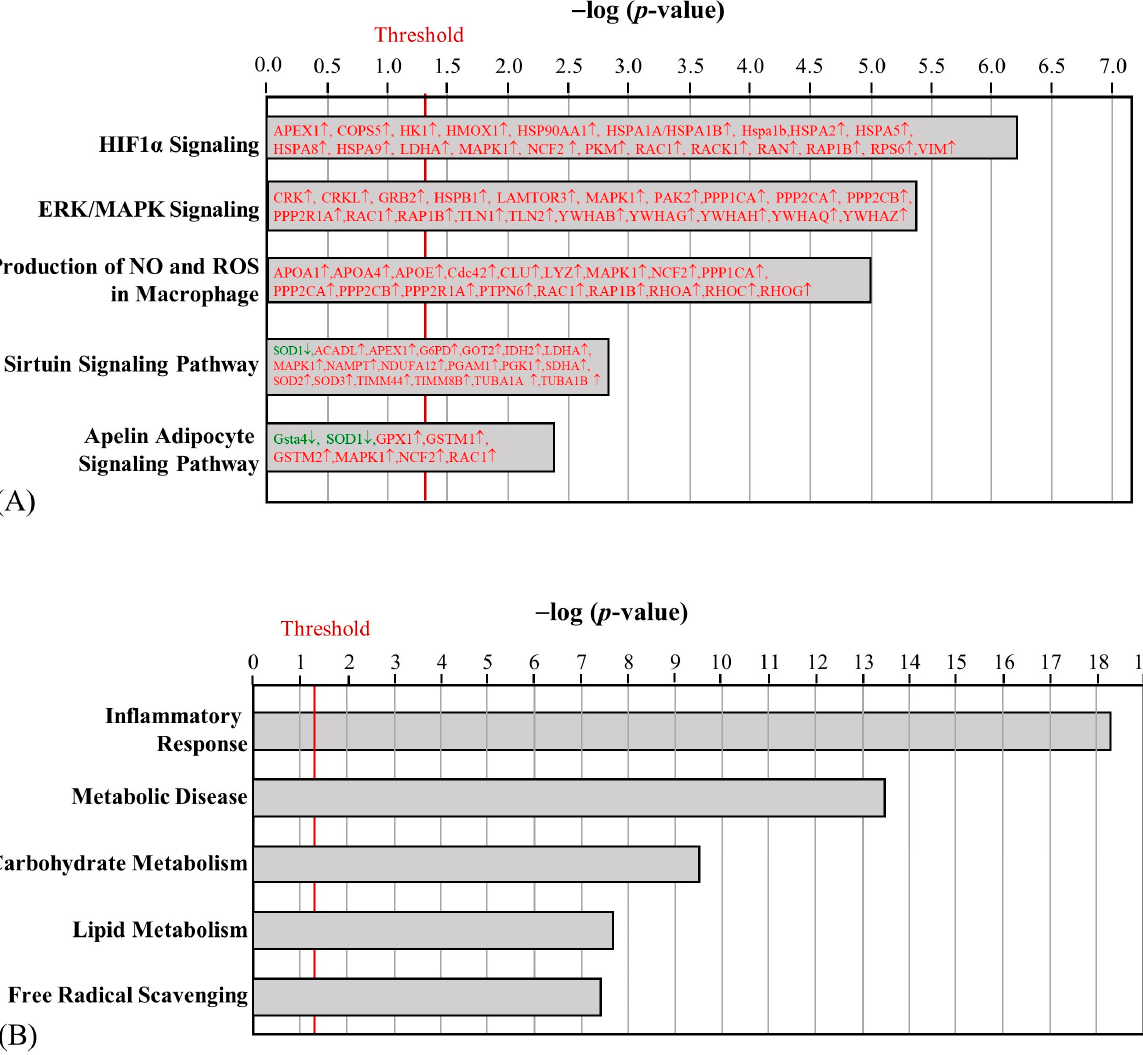
Figure 5. Effect of HFD on the canonical pathways ( A ) and biofunctions ( B ) regulated by EFP proteins between the NC and HFD groups. (The proteins with red letters were upregulated, whereas those with green letters were downregulated).